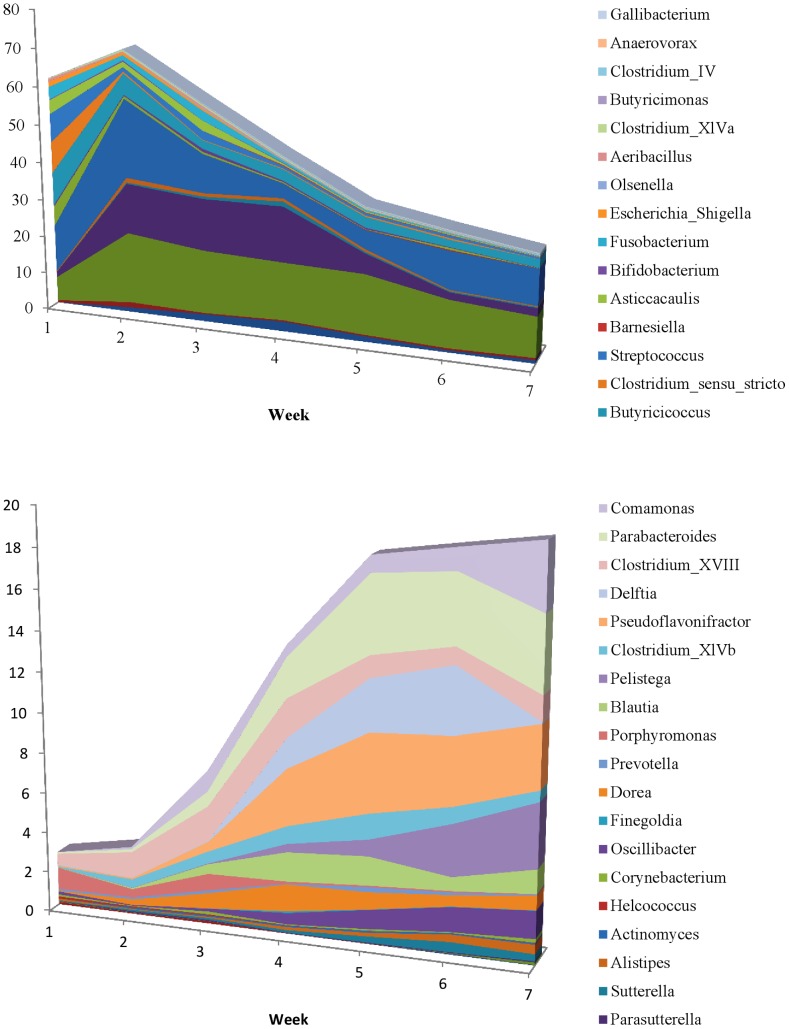
Prevalences of genera that were found to be significant for the discriminant analysis of fecal microbiome by week of life.Genera that showed higher prevalences during the first weeks of life are presented in the top graph. Genera that showed higher prevalences during the last weeks of the pre-weaning period are presented in the bottom graph.